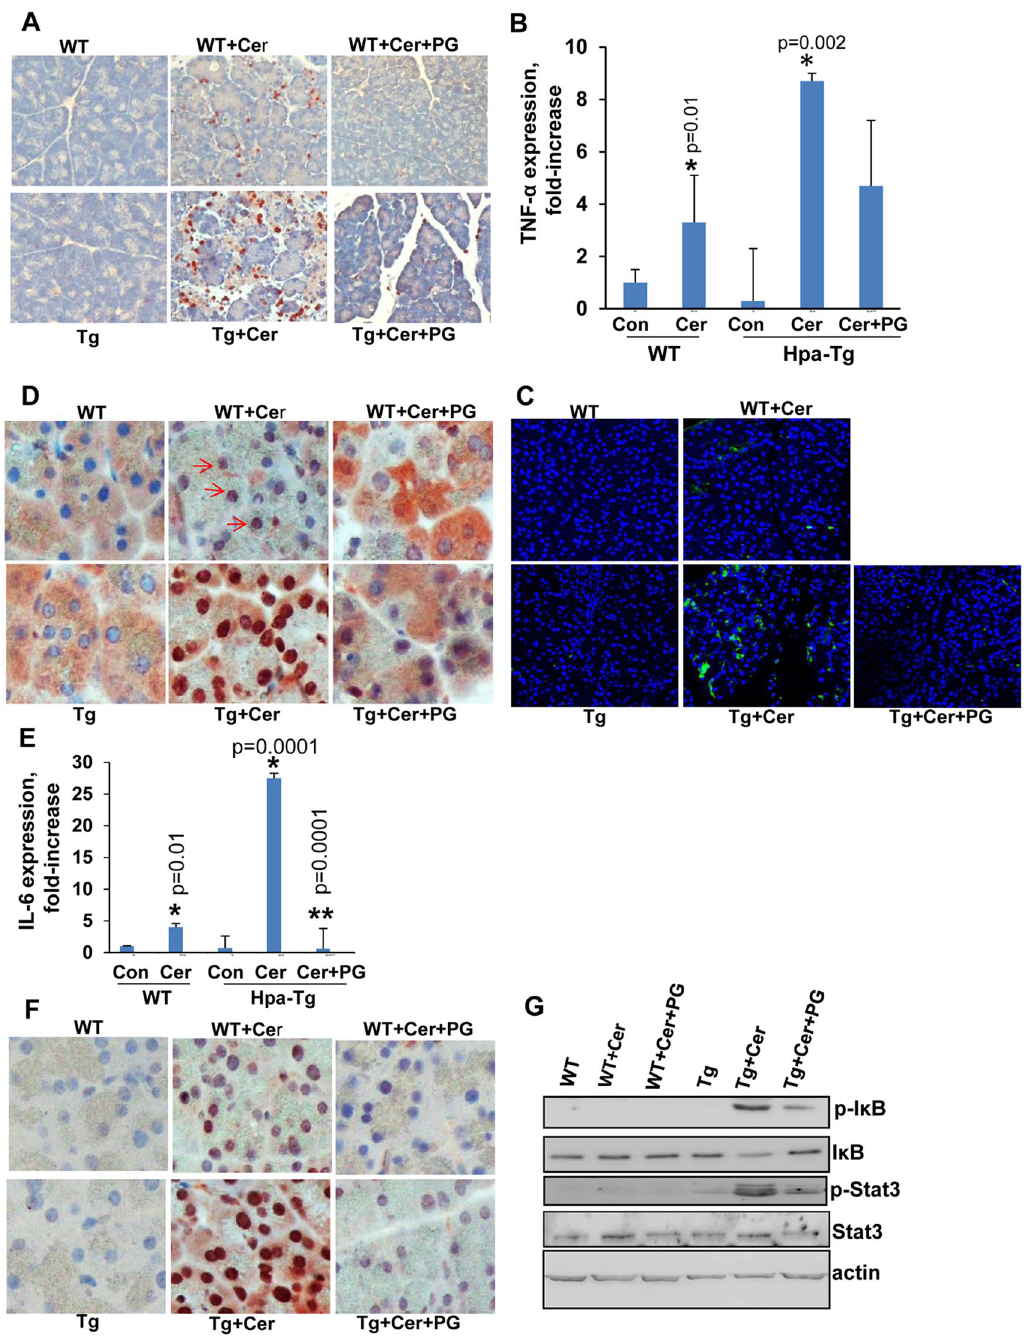
Figure 3. Pancreas inflammation, cytokine induction and signaling pathways evoked by cerulein are attenuated by heparanase inhibitor. WT and Hpa-Tg mice were injected with saline (left panels) or cerulein in the absence (middle panels) or presence (right panels) of PG545 pretreatment. Pancreas tissues were collected 24 h thereafter, and 5 micron sections from formalin-fixed, paraffin-embedded samples were stained for neutrophils infiltration ( A ), p65 ( D ) and phospho-STAT3 ( F ). Immunofluorescent staining of corresponding sections for TNF α (green) is shown in ( C ) along with nuclear counterstaining (blue). Shown are representative photomicrographs at x10 ( A ) and x40 ( C,D,F ) original magnification. Total RNA was extracted from corresponding pancreas tissues and subjected to real-time PCR analyses applying primers specific for TNF α ( B ) and IL-6 ( E ). Relative gene expression (fold-increase) is shown graphically in relation to the levels in control pancreas set arbitrarily to a value of 1. * p < 0.01 for control vs. cerulein; ** p < 0.001 for cerulein vs. cerulein + PG545. ( G ) Immunoblotting. Protein extracts from corresponding pancreas tissues were subjected to immunoblotting applying anti-phospho-I κ B (upper panel), anti-I κ B (second panel), anti-phospho-STAT3 (third panel), anti-STAT3 (fourth panel) and anti-actin (lower panel)